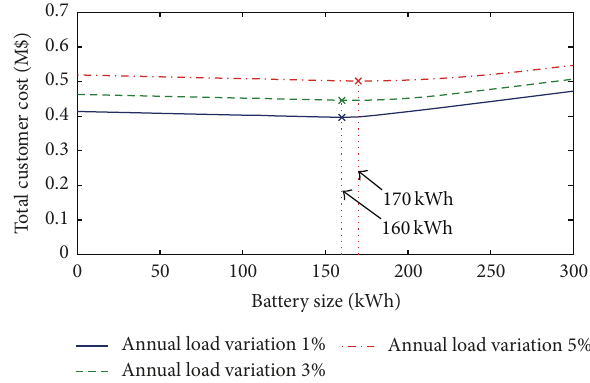
= 95 %, ch Figure 4: Total customer cost with an annual load variation of 5%, = 95 %, and 𝜂 = 98 % and for different values of 𝛼 and 𝛽 𝜂 ch dch (residential load).